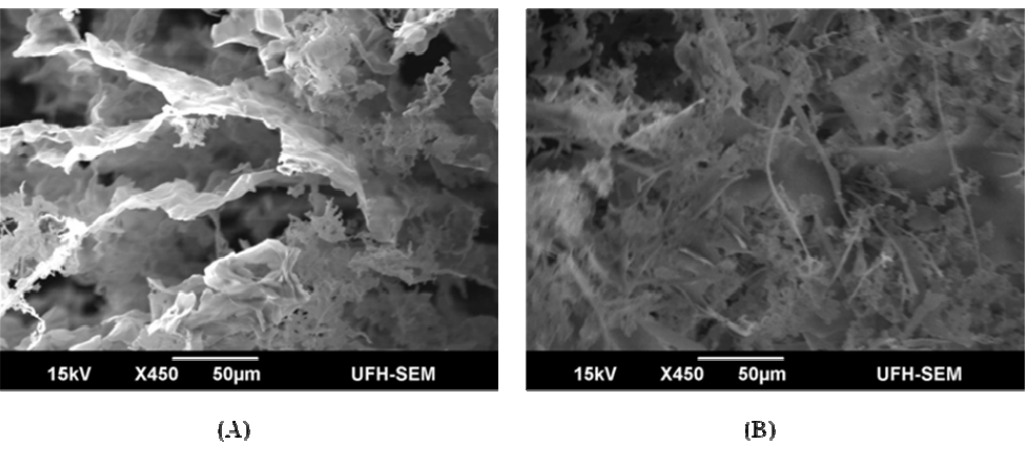
Figure 6. Scanning electron (SEM) micrograph of purified bioflocculant from Brachybacterium sp. UFH: ( A ) PPB; ( B ) CPB.